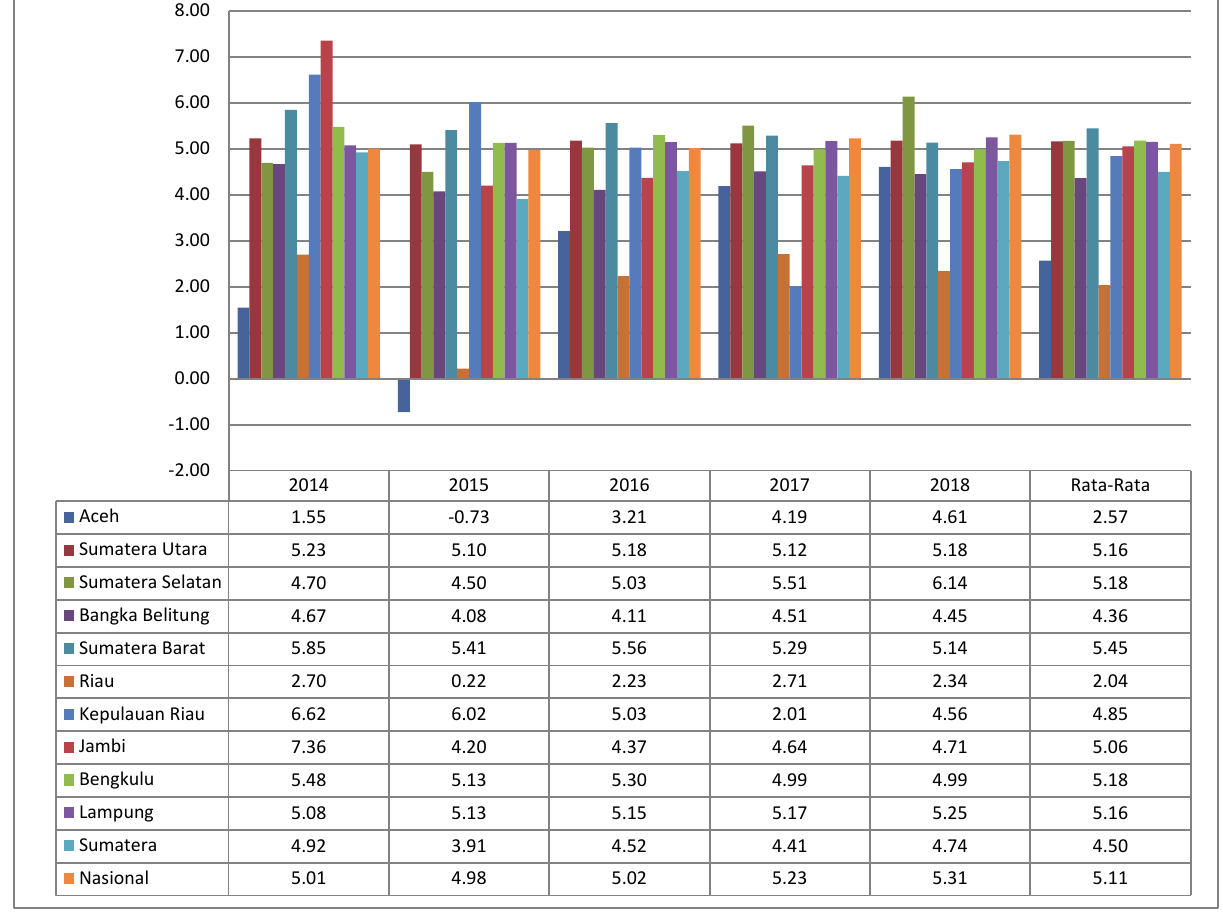
Fig. 1. The Economic Growth Rate of 10 Provinces on the Island of Sumatra for the 2014 - 2018